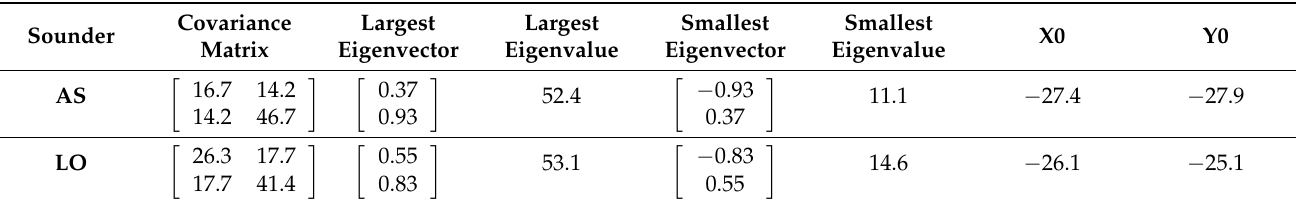
Table 1. 95% confidence error ellipse results. The centre of the ellipse is at (X0, Y0).